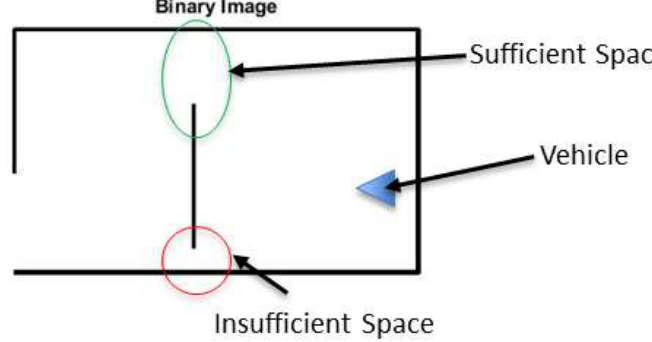
Figure 3. Binary image for indoor environment.